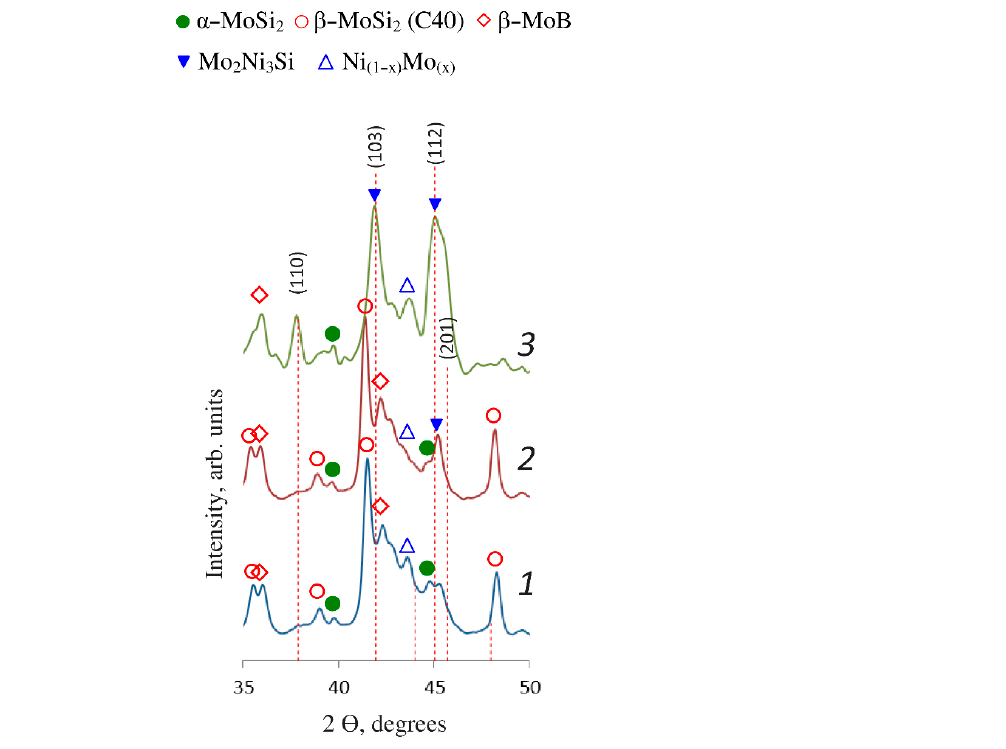
Figure 4. Regions of the XRD patterns of the coating after annealing at 600 °C (1), 700 °C (2), and 800 °C (3). Dashed lines correspond to the Mo 2 Ni3Si phase (ICDD database, card No. 01-089-5030). Table 3. Phase composition of the coating after annealing at indicated temperatures.